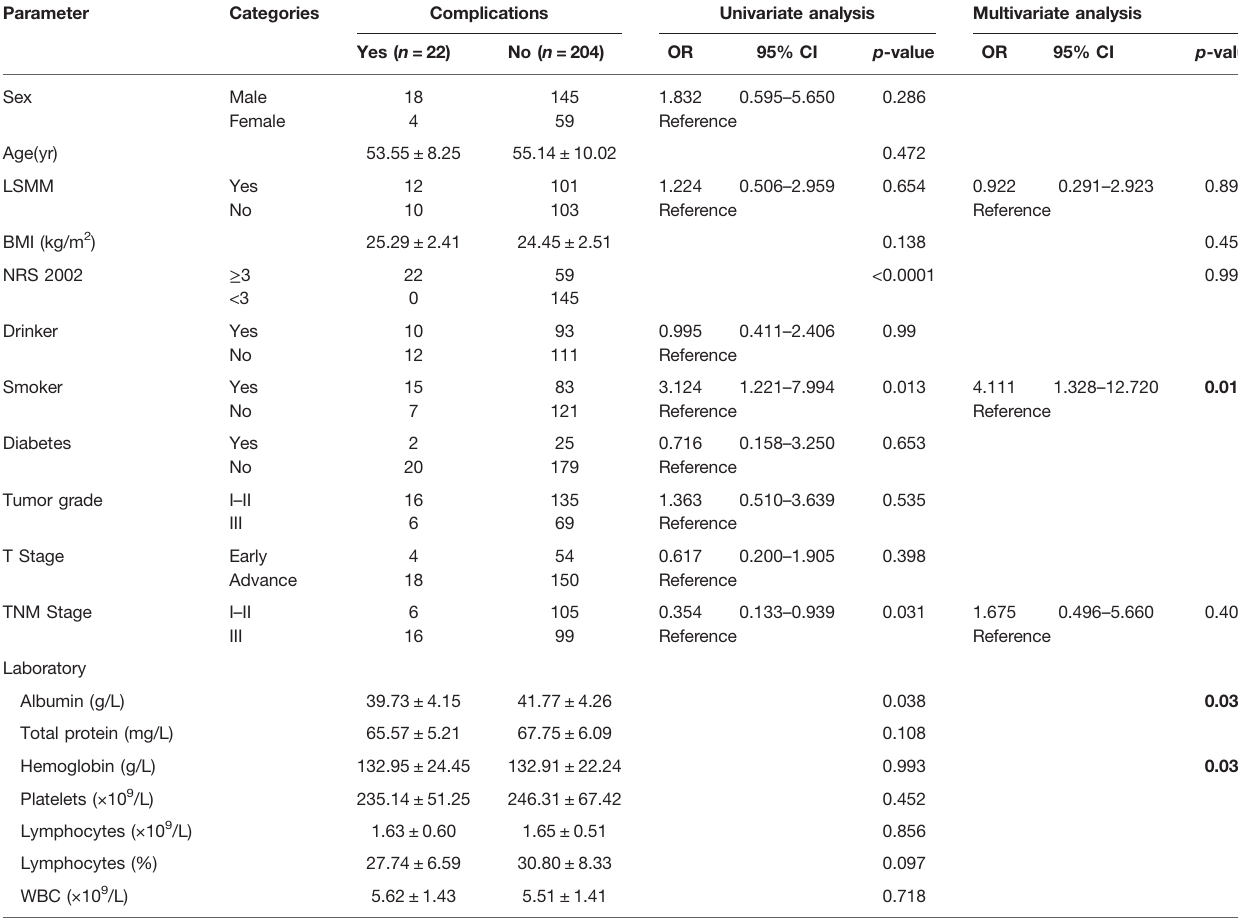
TABLE 4 | Univariate and multivariate analysis of risk factors for postoperative